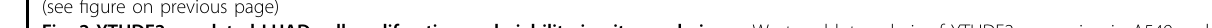
Fig. 2 YTHDF2 regulated LUAD cell proliferation and viability in vitro and vivo. a Western blot analysis of YTHDF2 expression in A549 and H1792 cells infected with two independent shRNAs targeting YTHDF2 or a control shRNA. b Trypan blue live cell count assays were performed to determine cell growth after YTHDF2 knockdown in A549 and H1792 cells. c Western blot analysis for YTHDF2 expression in A549 and H1792 cells that were lentivirally infected with YTHDF2 or a control vector. d Trypan blue live cell count assays were performed to determine cell growth after YTHDF2 was over-expressed in A549 and H1792 cells. e Colony formation assays of A549 and H1792 cells described in a . f Colony formation assays of A549 and H1792 cells described in c . A549 cells with empty vector or YTHDF2 knockdown vectors were subcutaneously injected into nude mice. h Tumor size was measured every 3 days, and growth curves were plotted. Tumors were dissected from nude mice of each group and photographed at 32 days after transplantation, and the size and weight of tumors were measured ( g , i ). All data and error bars are presented as the mean ± SDs. * P < 0.05, ** P < 0.01, and *** P < 0.001 compared with control